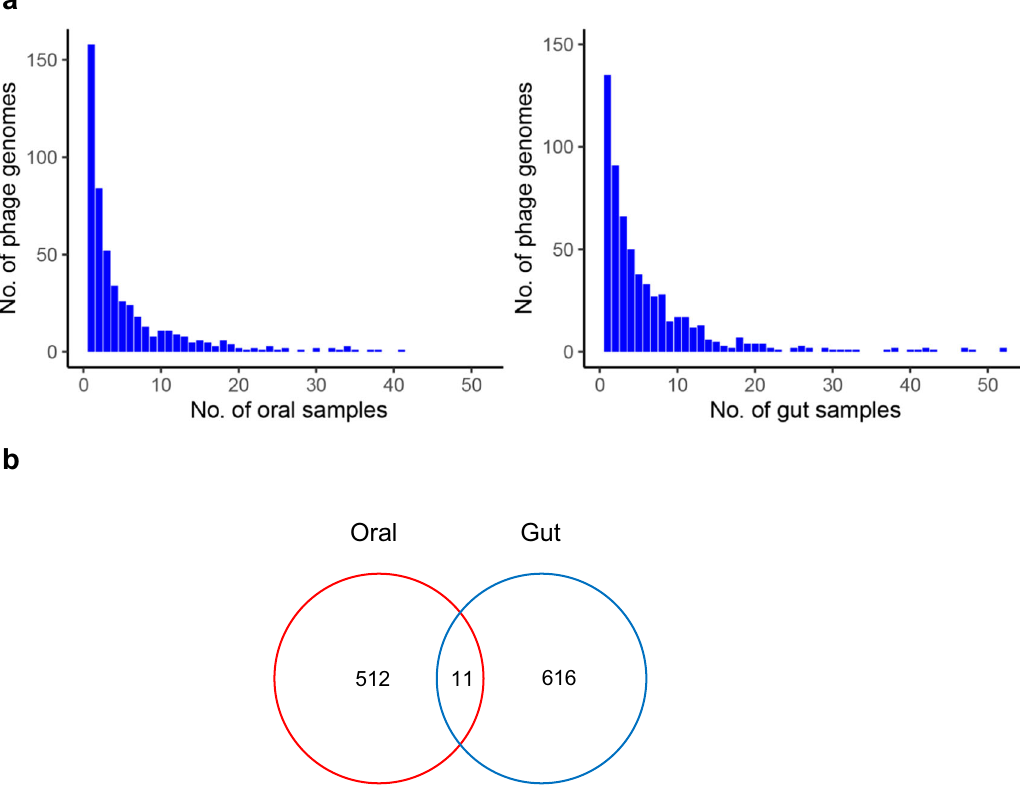
Fig. 2 Inter-individual diversity and intra-individual connections of the oral and gut phages communities. a The prevalence of phage genomes (>10% genome content identity) in oral (left) and gut (right) samples from different individuals. b A Venn diagram displaying the shared phages between the gut and oral phage ensembles on the threshold of sequence identity